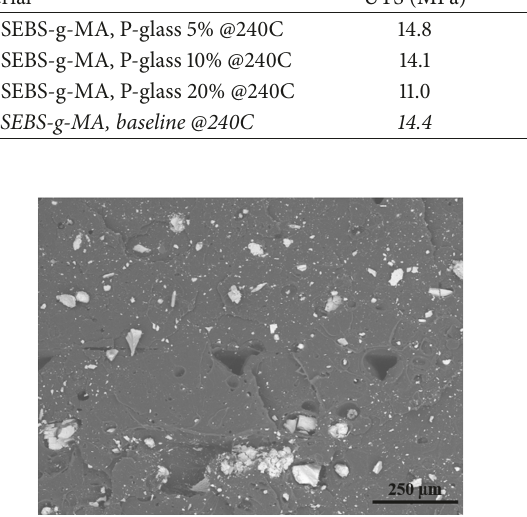
Table 3: Tensile rest results for ABS:SEBS-g-MA loaded with P-glass at various weight percentages. Material